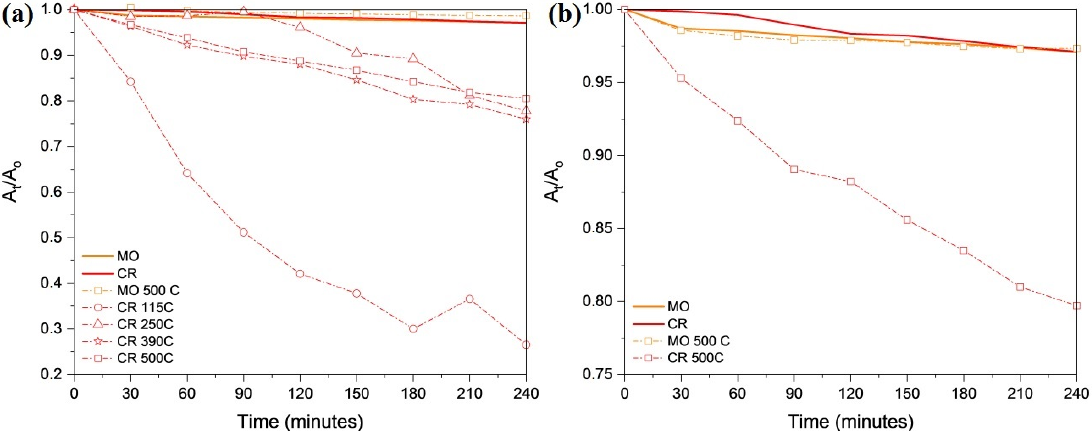
Figure 14. Photocatalysis of decomposition intermediates and products forming from compound 1 at various temperatures under nitrogen ( a ) and air ( b ) during the photodecomposition of Congo red. Figure 14 shows that among the two studied dyes, Methyl orange and Congo red; only the